Question: Sum up the contents of this chart in one sentence.
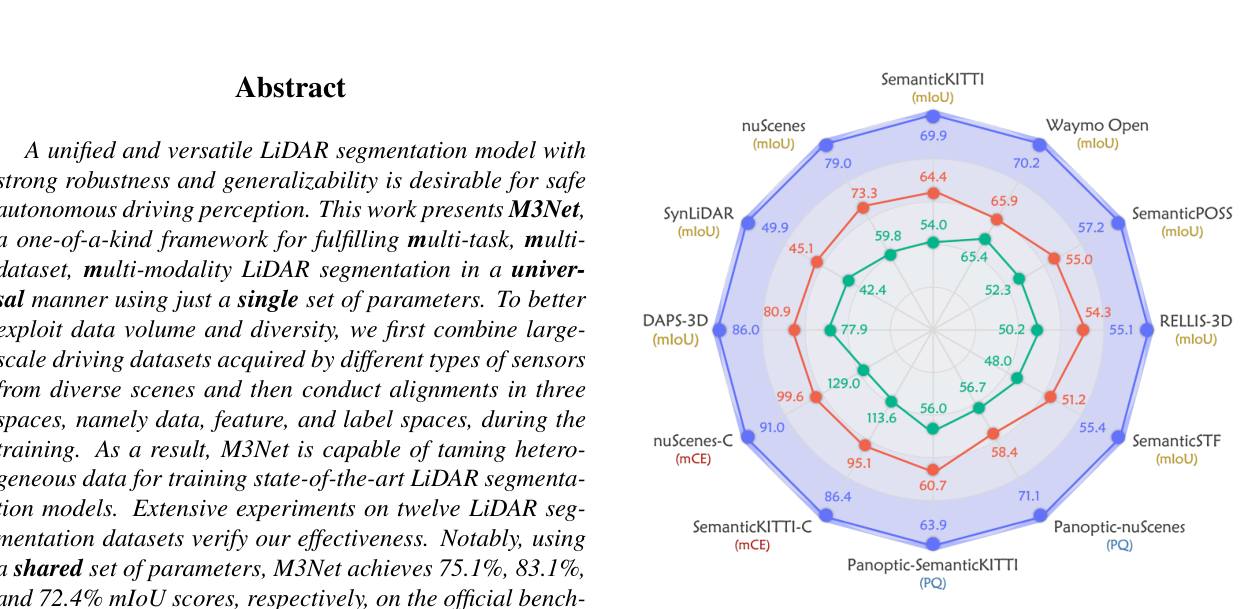
Answer: Performance comparisons among M3Net [•], Single- Dataset Training [•], and Na¨ıve Joint Training [•] across twelve LiDAR segmentation datasets. For better comparisons, the radius is normalized based on M3Net’s scores. The larger the area cover- age, the higher the overall performance. Best viewed in colors.